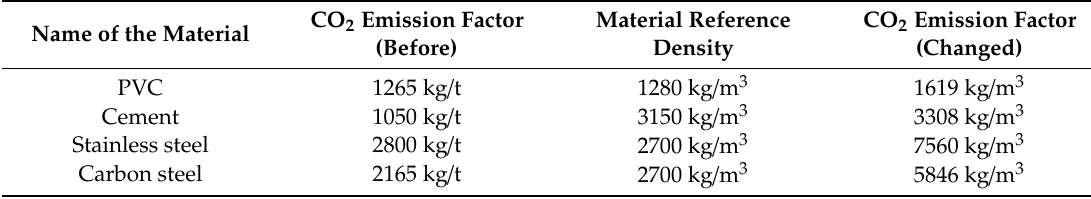
Table 2. The changed CO 2 emission